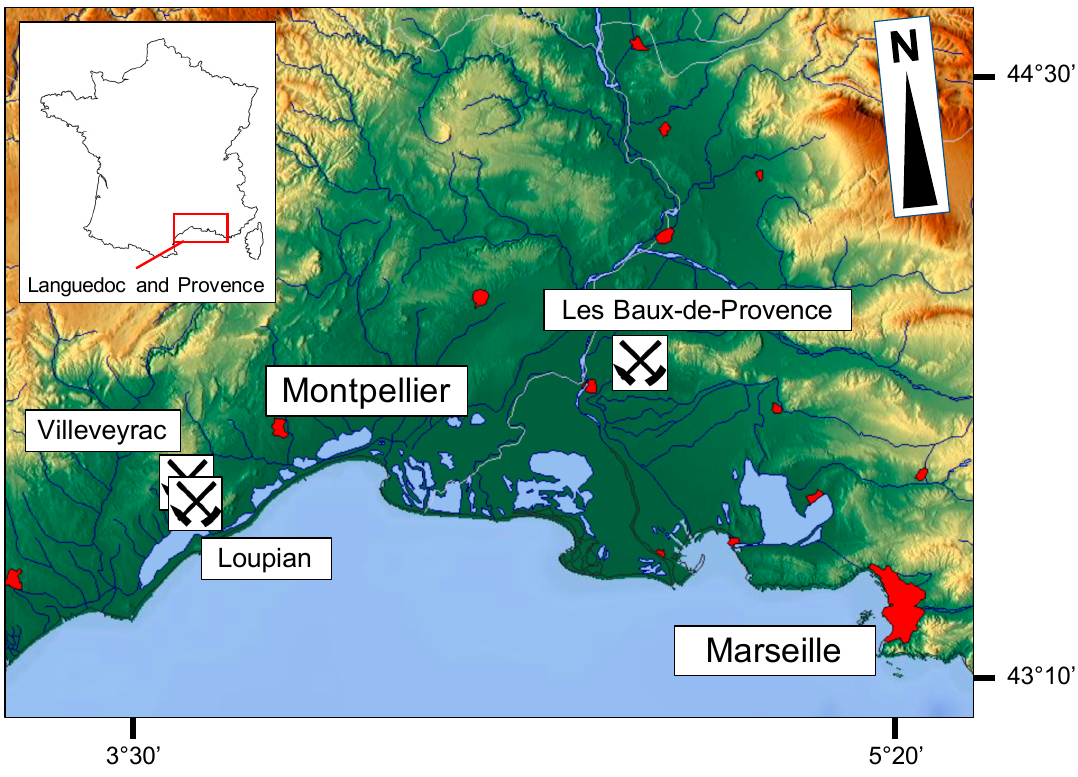
Figure 1. Relief map of Provence and Languedoc (southern France), with the approximate positions of the old bauxite mines object of sampling (https://maps ‐ for ‐ free.com).